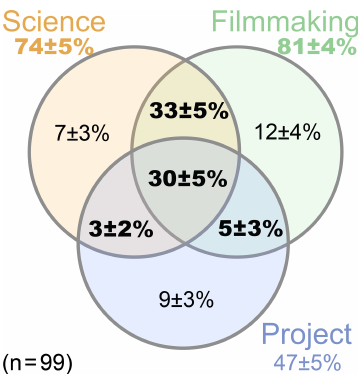
Figure 2. Venn diagram of people’s reasons for registering inter- est with SSFX. Bold values denote statistically significant differ- ences from pure randomness (expected 57% in each overall set, 14% in each region), taking into account multiple comparisons ( α Bonf = 0 . 017 for sets and α Bonf = 0 . 0071 for regions). Created in part using InteractiVenn (Heberle et al.,